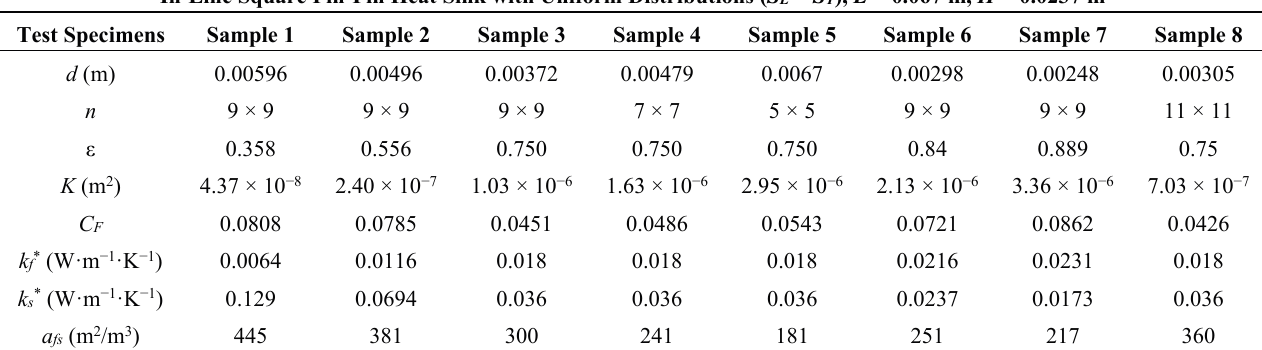
Table 1. Porous properties of pin-fin heat sinks used